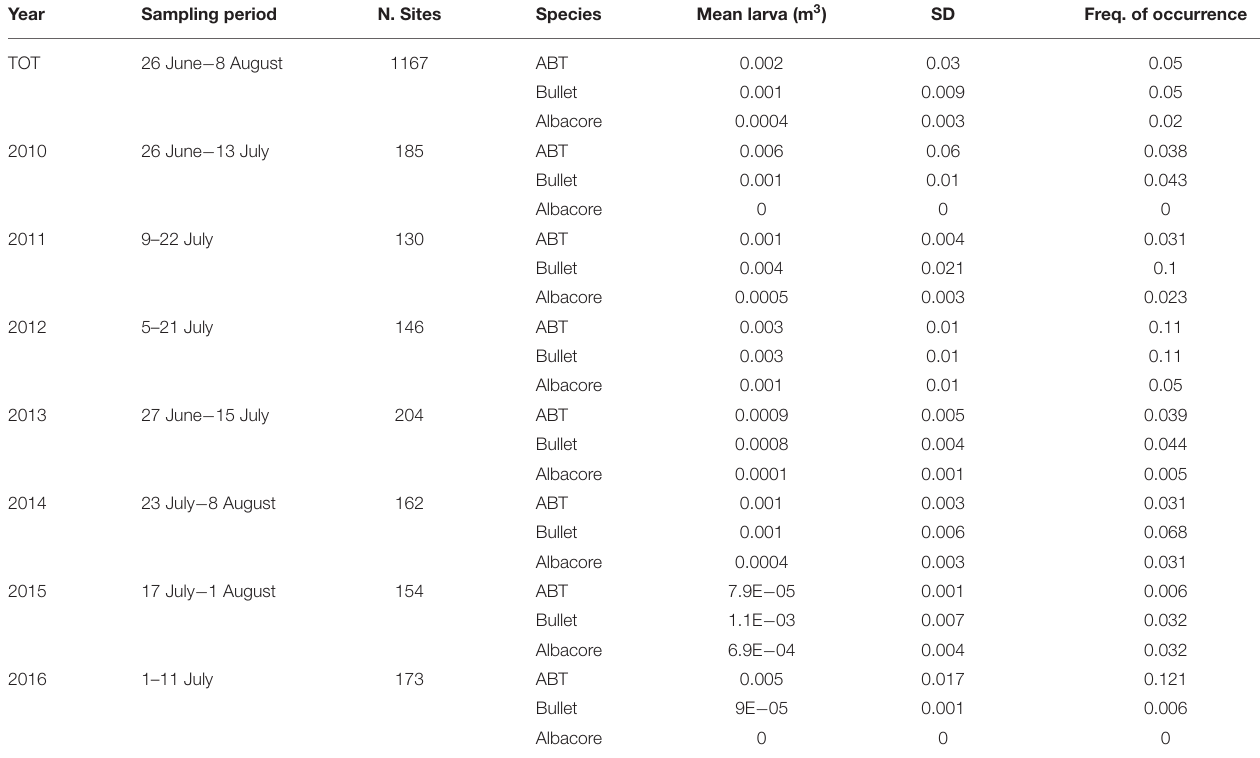
TABLE 1 | Information on sampling strategy and statistics for the three tuna species. Year Sampling period N.